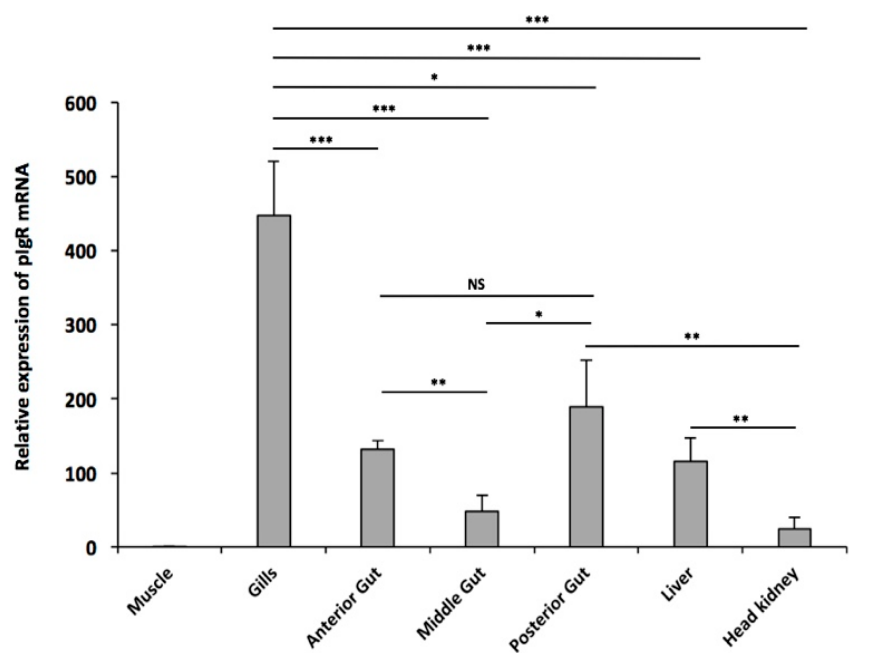
Figure 12. Relative expression levels of pIgR in different tissues from T. bernacchii . Data from three independent experiments are presented as mean gene expression relative to the housekeeping β -actin ( ± SD). The muscle tissue was used as a negative control. Levels of transcription were evaluated by q-PCR in duplicates using three T. bernacchii specimens. * p < 0.05; ** p <0.01; *** p < 0.001; NS, not significant (two-tailed Student’s t test with Bonferroni correction).